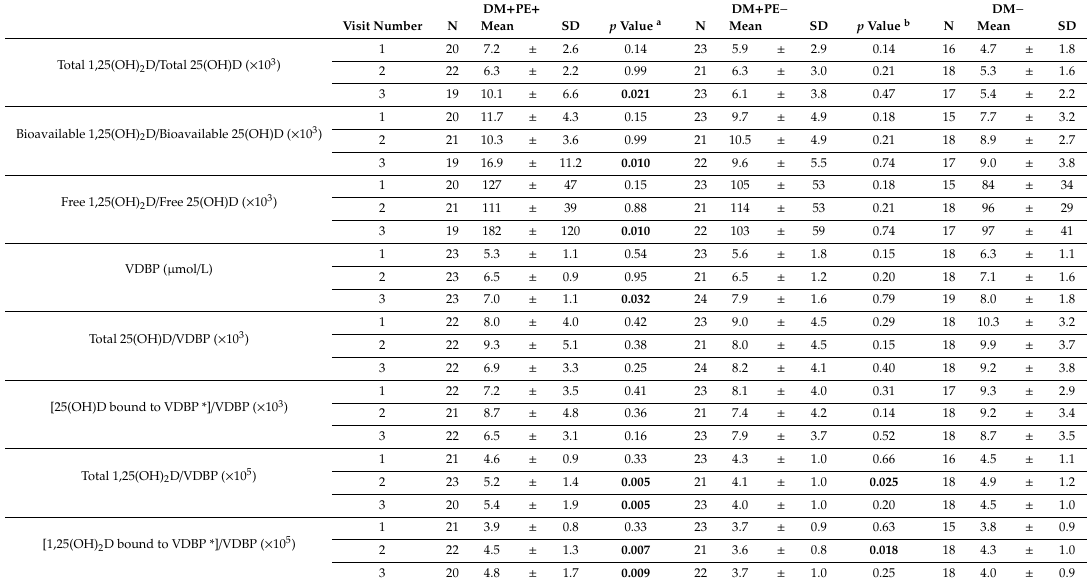
Table 2. Molar ratios of 1,25(OH) 2 D to 25(OH)D; vitamin D binding protein (VDBP) concentrations; and molar ratios of vitamin D to VDBP.